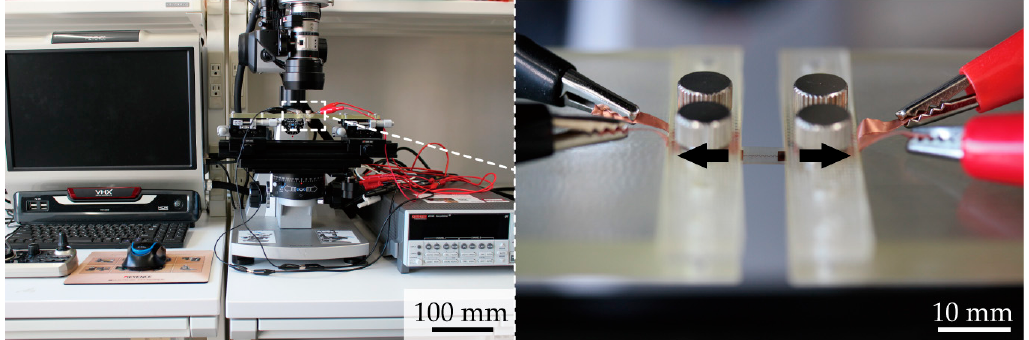
Figure 4. Images of the experimental setup.